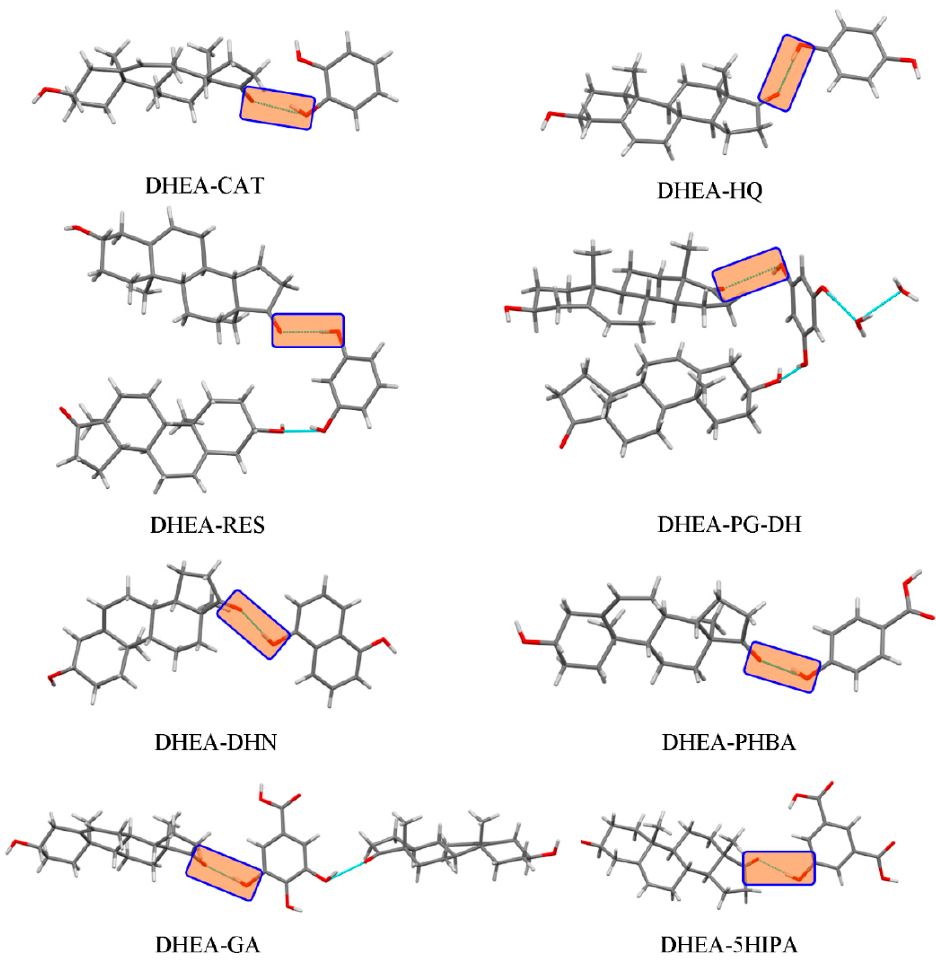
Figure 2. ASU of DHEA cocrystals with C=O···HO-Ar synthon highlighted. DHEA-CAT cocrystal (1:1). The DHEA-CAT crystalizes in the orthorhombic P 2 1 2 1 2 1 space group with Z = 4 (the Z number represents the cocrystal formula in a unit cell). The ASU of DHEA-CAT contains one DHEA molecule and one CAT molecule (Figure 2). Two molecules are connected through C=O···HO-Ar synthon O2···H3A-O3 (2.726 Å) as ex- pected. Then 1D infinite hydrogen-bonding chain is formed via O4-H4···O1 (2.763 Å) in- teractions in Figure 3a.